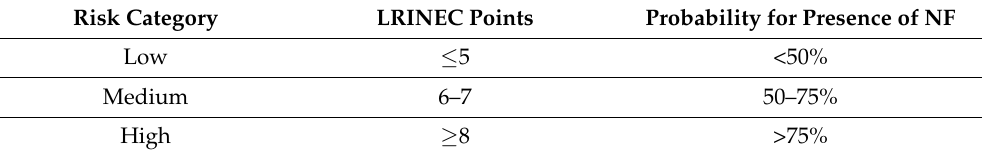
Table 2. LRINEC risk assessment (based on